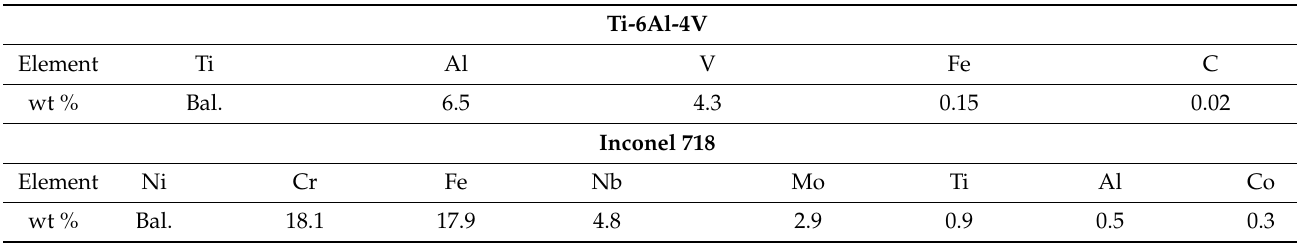
Table 2. The chemical compositions of the